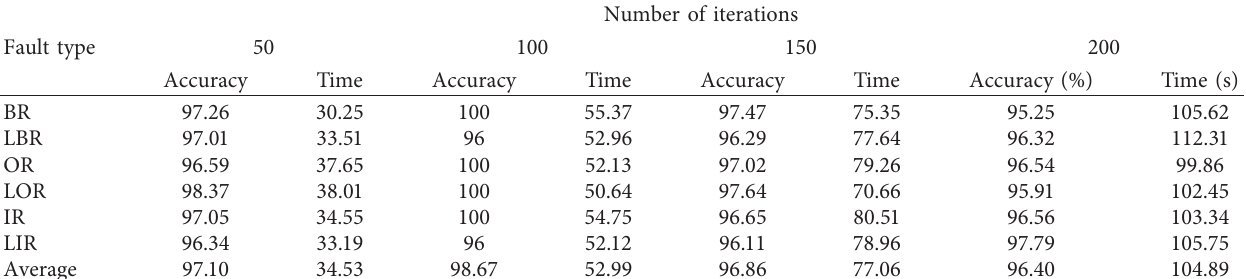
Table 5: Fault diagnosis accuracy and time under different iteration number working conditions.